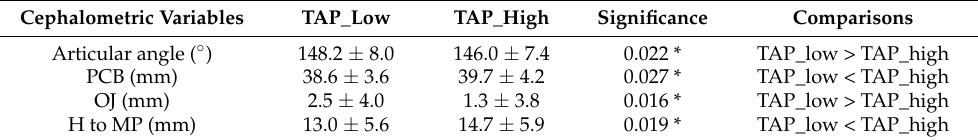
Table 3. Comparisons of cephalometric variables between TAP_low and TAP_high groups (n = 194). * Cephalometric Variables